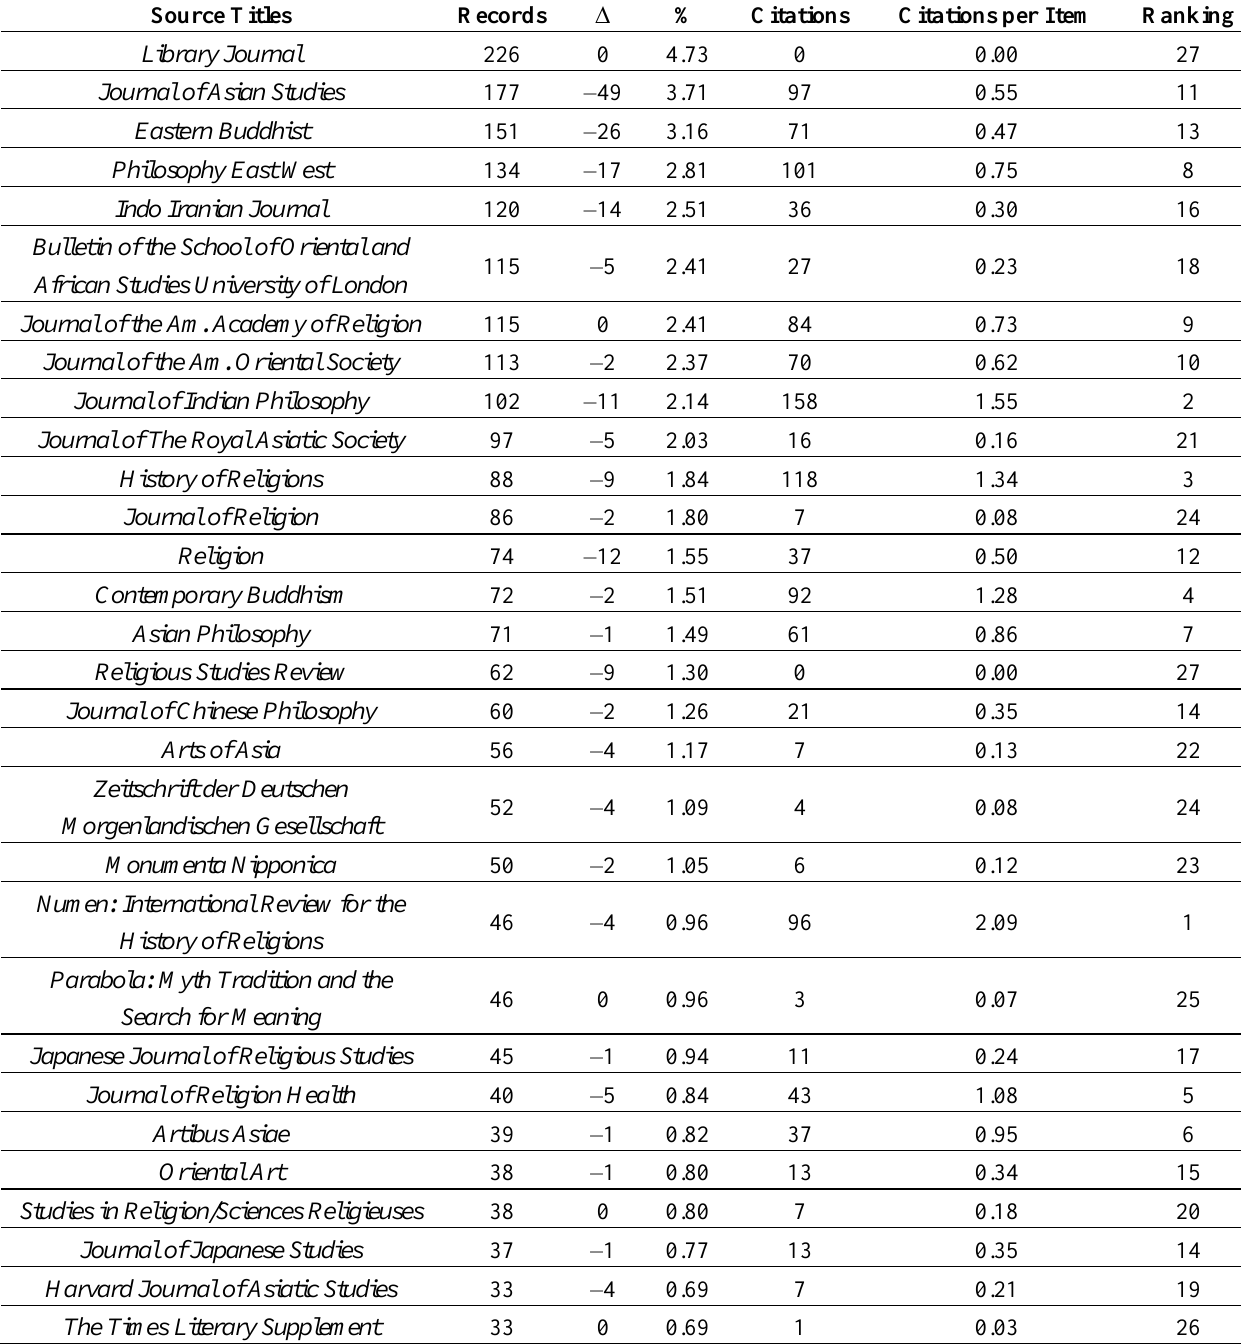
Table 7. The top 30 Source Titles in order of number of scholarly communications